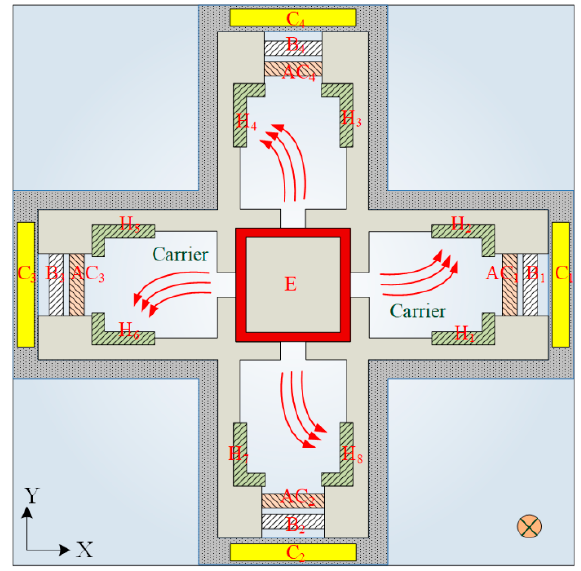
Figure 3. Carrier path in the MMF sensor under z ‐ direction MF. H, Hall electrode, E, emitter.